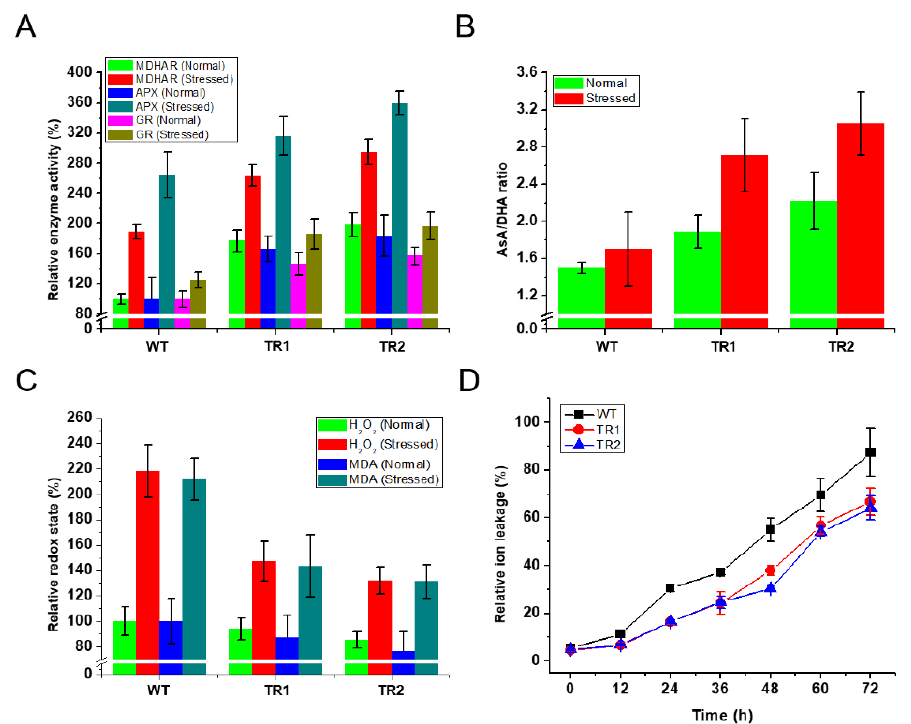
Figure 2. Ascorbate pool and redox homeostasis of transgenic and wild-type rice plants under conditions of salt stress. ( A ) Four-week-old seedlings were exposed to 100 mM NaCl for 4 days at 28–32 ◦ C, and then leaf tissues were harvested for evaluating enzymatic activity, ( B ) AsA/DHA ratio, ( C ) hydroperoxide level and ( D ) ion leakage analyses. Except for the results of the ion leakage analyses, data are expressed as relative percentages of the levels observed in WT plants and represent the means ± SD of at least three replicates from three independent experiments. Ion leakage was calculated by adjusting ion release at the initial time (0 h) in both the WT and transgenic plants. WT, wild-type rice; TR, transgenic rice; AsA, ascorbate; DHA, dehydroascorbate; normal, salt-free conditions; stressed, salt-treated conditions; H 2 O 2 , hydrogen peroxide; MDA, malondialdehyde; MDHAR, monodehydroascorbate reductase; APX, ascorbate peroxidase; GR, glutathione